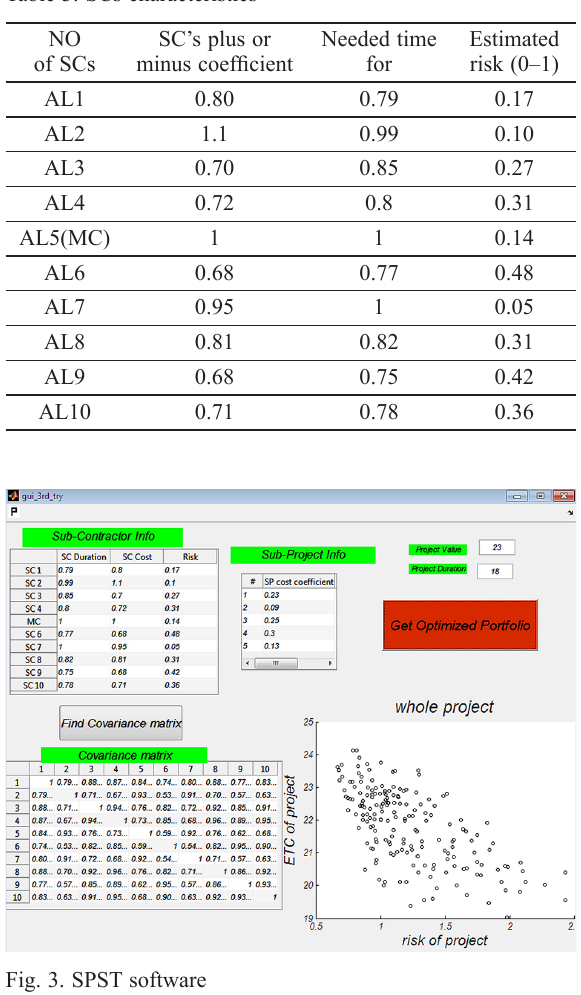
Table 3. SCs characteristics